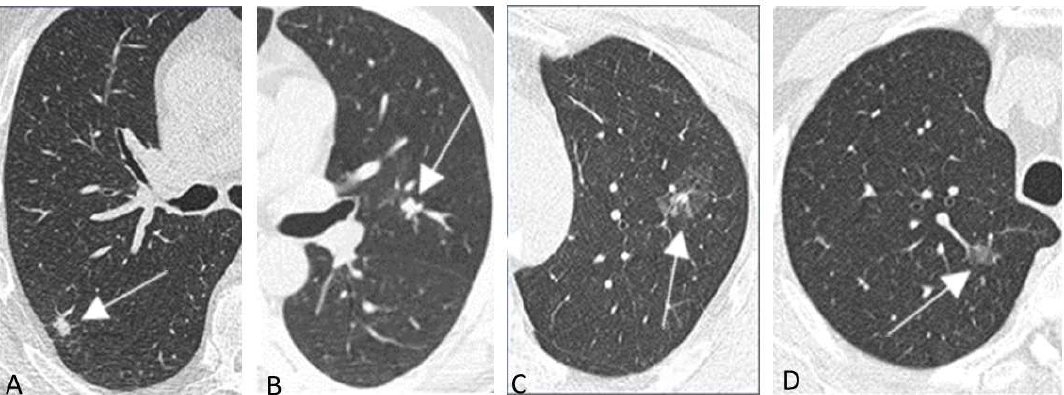
Figure 1. ( A – D ) Nodular presentations of early stage lung cancer and precancerous lesions in baseline chest low-dose CT screening in four subjects. Lung cancers (arrows) appearing as solid [( A ) stage I adenocarcinoma; ( B ) stage I squamous cell carcinoma] or part-solid ( C ) stage I adenocarcinoma) nodules. Atypical adenomatous hyperplasia (arrow) appearing as a pure ground glass nodular opacity ( D ).